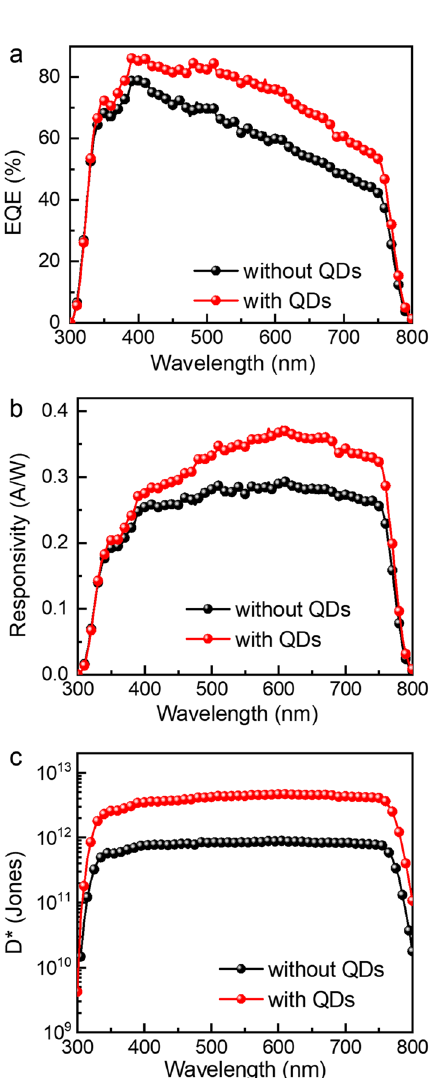
Fig. 7 a EQE spectra, b R plots and c D* curve of the control device and the device passivated by the QDs